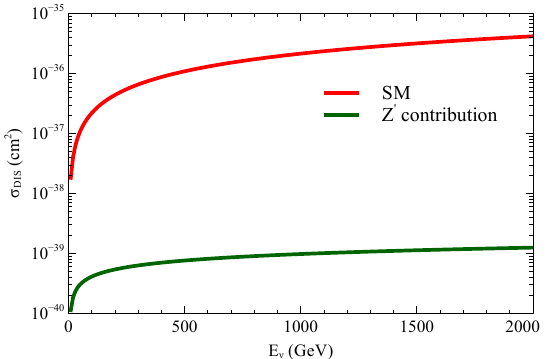
Figure 8 . The SM NC DIS cross section, compared to that obtained from our model. The parameter values used in calculating the Z 0 contribution are given in table